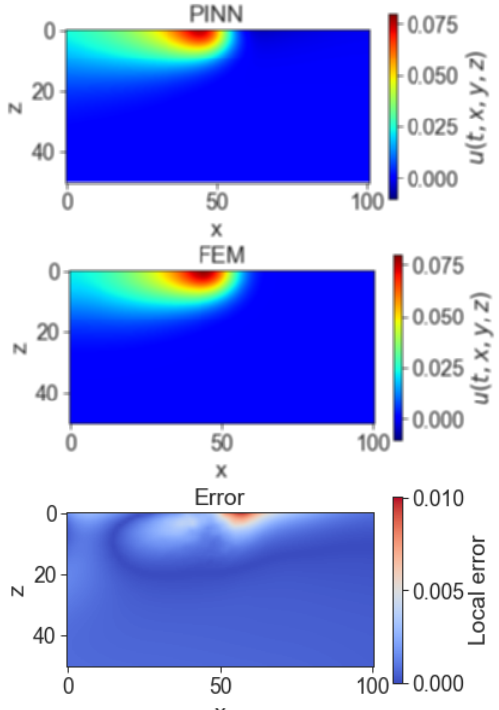
Fig. 3. Comparison of a spatial temperature profile at a given point in time calculated using (i) a PINN (upper panel), (ii) a FEM simulation (middle panel) and (iii) the error measured by the absolute difference between both results (lower